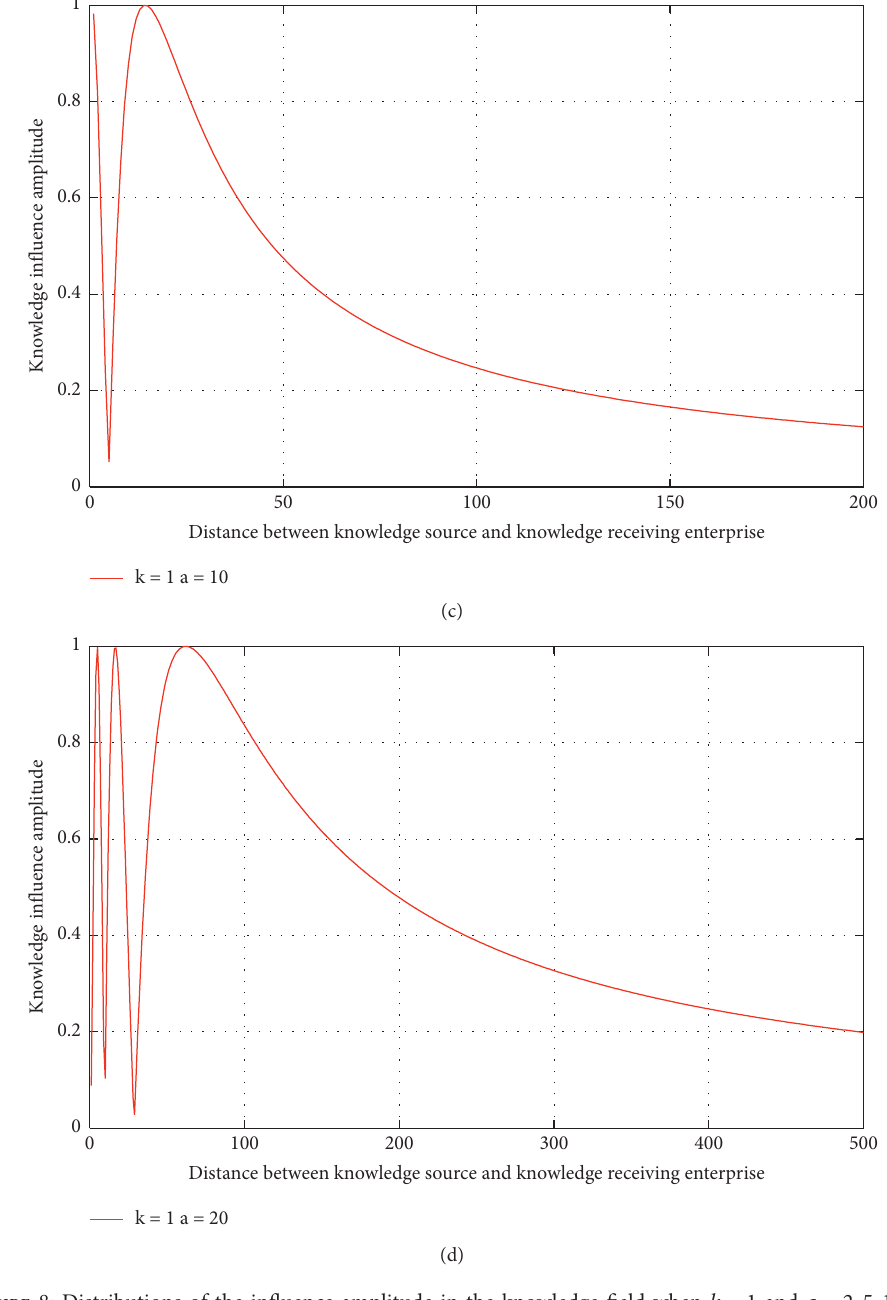
Figure 8: Distributions of the influence amplitude in the knowledge field when k � 1 and a � 2 , 5 , 10 ,